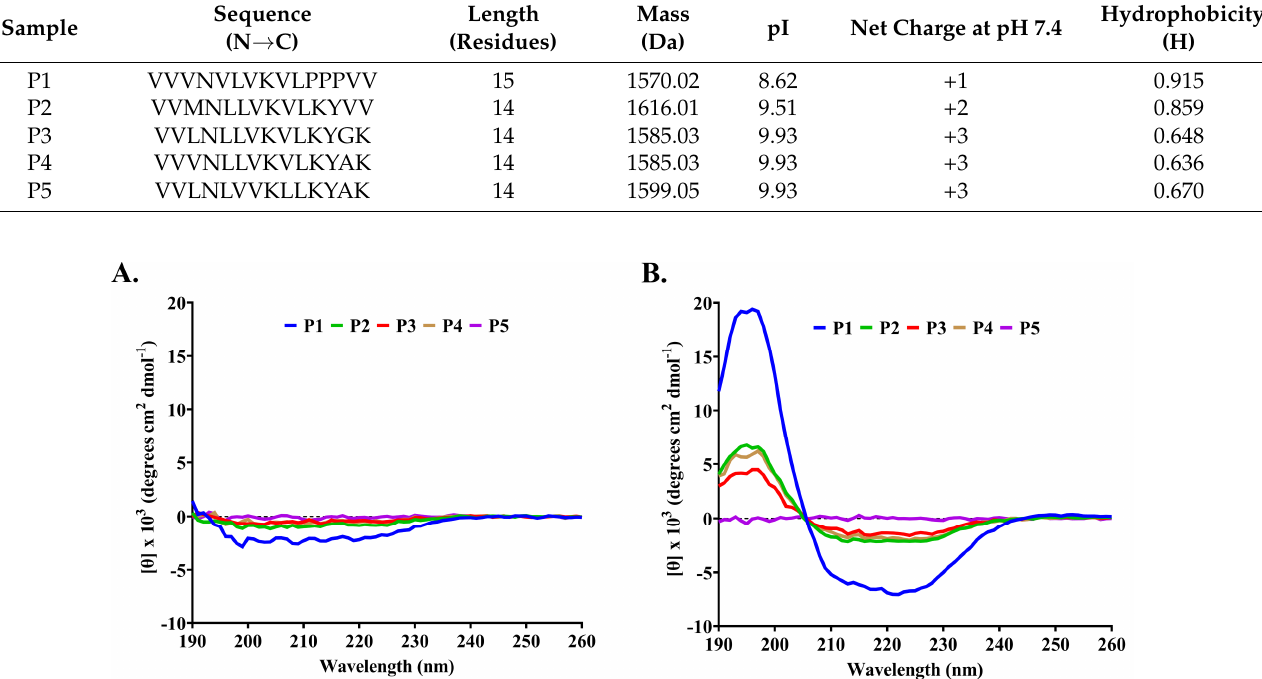
Figure 2. De novo peptide sequencing of the anti-MRSA peptides from SPR-20. The fragmentations to generate the b- and y-ions of five peptides (P1–P5) were analyzed by a tandem mass spectrometer, and the corresponding mass spectra are shown in ( A – E ), respectively. The peptide sequences were derived from the mass spectra, and the local confidence scores assigned to each amino acid are also shown. Table 3. Physicochemical properties of anti-MRSA peptides from SPR-20. The peptide sequences were obtained from de novo sequencing by LC-MS/MS. The predicted mass, pI, net charge, and hydrophobicity were calculated.